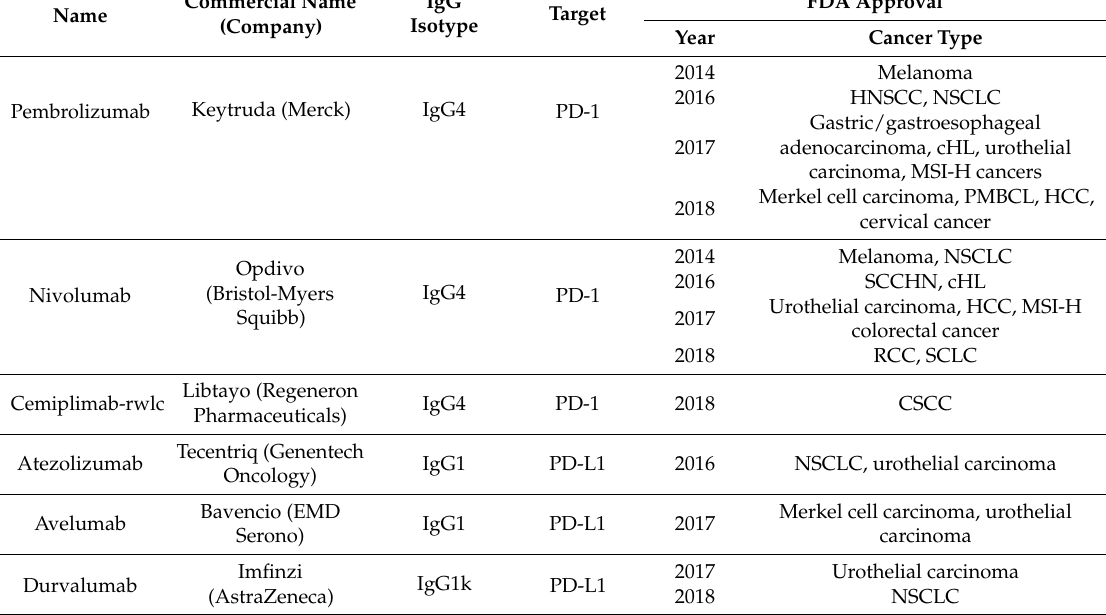
Table 3. FDA approved PD-1/PD-L1 inhibitors. HNSCC, head and neck squamous cell